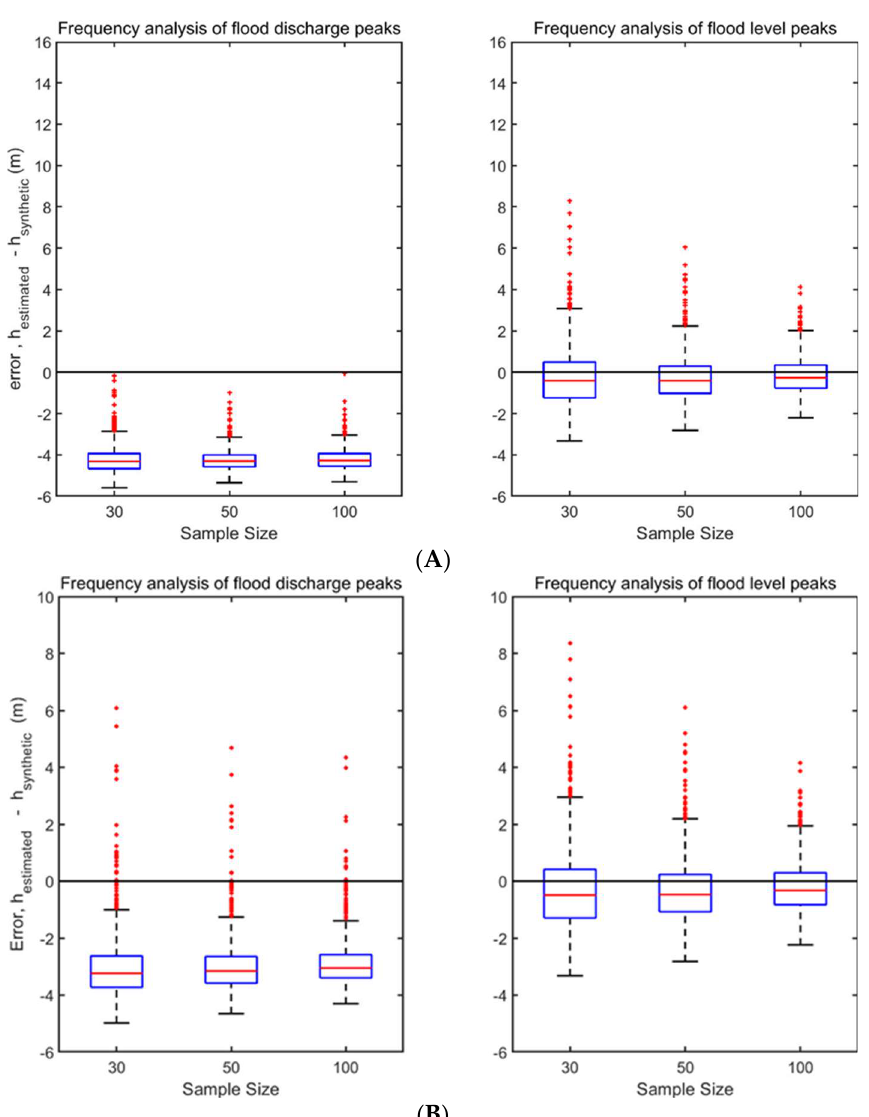
Figure 3. Boxplots of error estimates for the two approaches with Gumbel distribution used for design flood level estimation at cross-sections A and B . The red lines represent the median (50th percentile), the lower and upper ends of the blue box represent the 25th and 75th percentile, respectively. Outliers are represented by red dots.